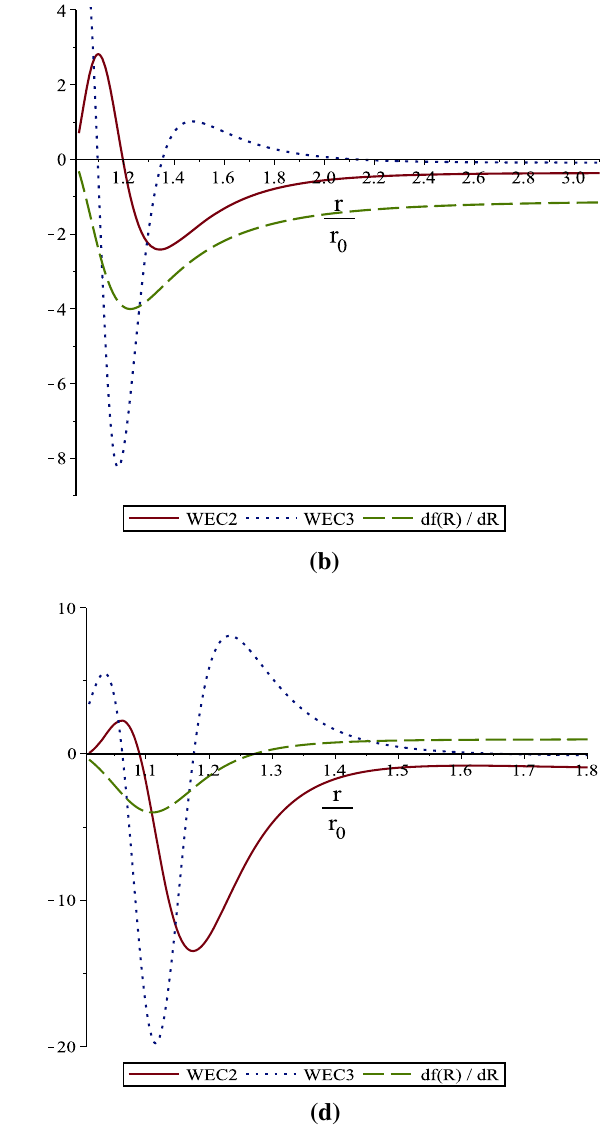
Fig. 8 The blue region in a , c show the asymptotically spherical (hyperbolic) wormhole solutions of the Tsujikawa model that respect the NEC. b Which is depicted by setting n = 4 . 5 , r 0 = 1, shows that F = df ( R )/ dR < 0 and the asymptotically spherical wormhole